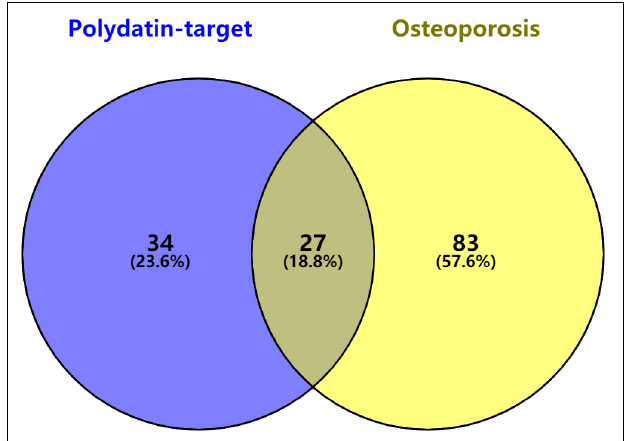
FIGURE 2 | Identification of KEGG pathways shared between polydatin-targeted genes and osteoporosis. Sixty-one polydatin-targeted genes related KEGG pathways, and 110 osteoporosis related KEGG pathways were found; 27 (18.8%) shared KEGG pathways were